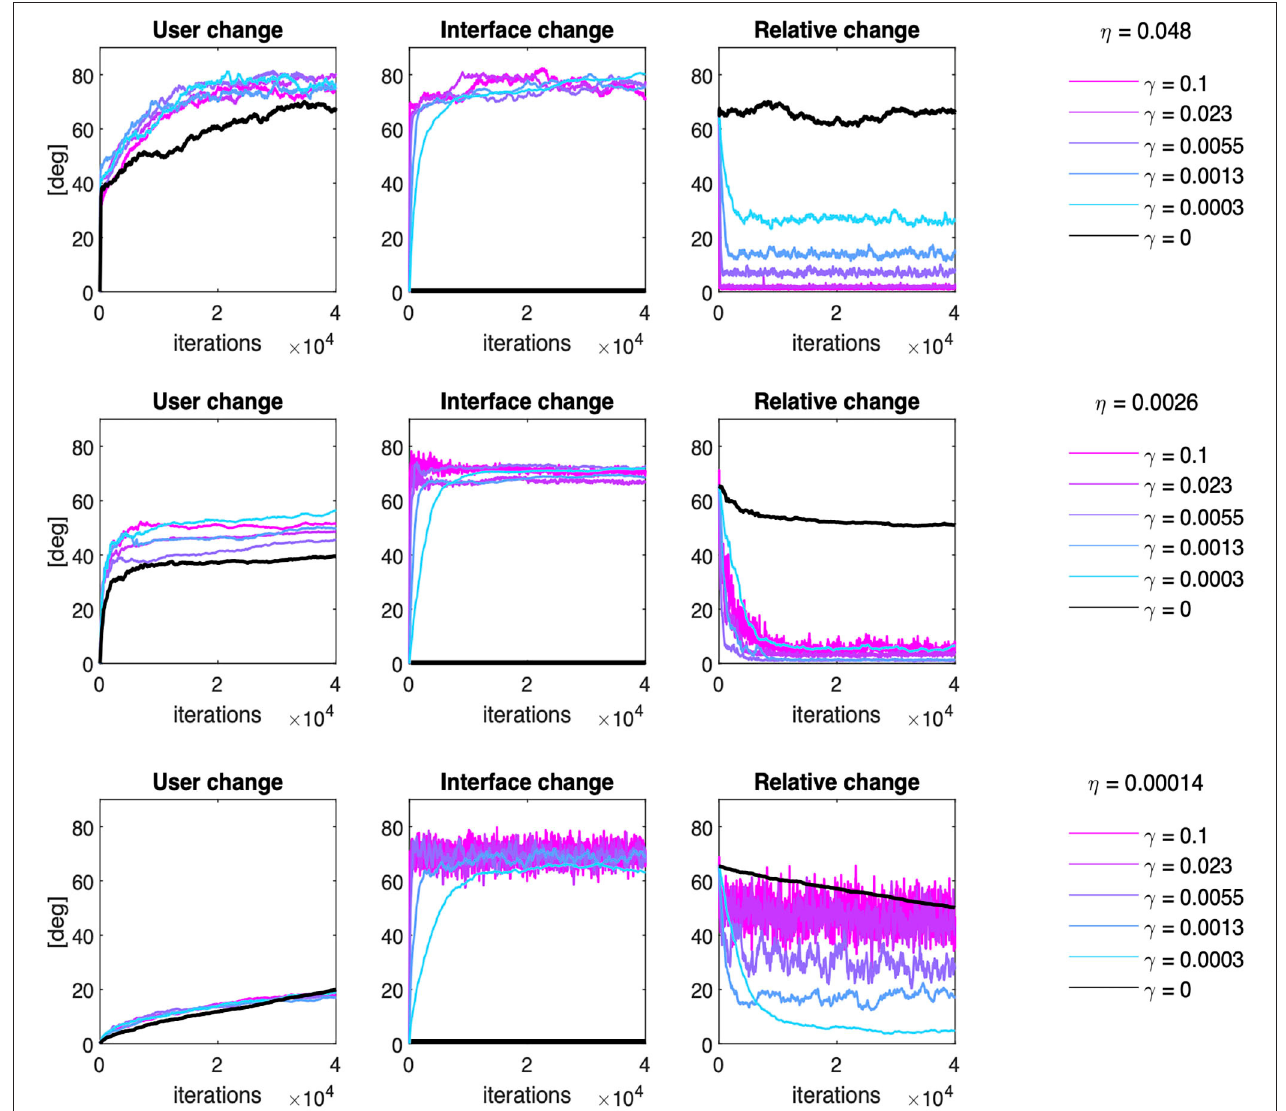
FIGURE 7 | Co-adaptation: examples of user and interface evolution though time. Effect of six different interface adaptation rates on the Subspace Angle of the simulated users relative to the initial condition (leftmost column), of the interface relative to the initial condition (middle columns) and the relative angle between the interface and the user at each training iteration (rightmost column). The effect of co-adaptation has been exemplified here for a slow-learning user ( η = 0.00014, bottom row), a user with intermediate learning rate ( η = 0.0026, middle row), and a fast-learning user ( η = 0.048, top